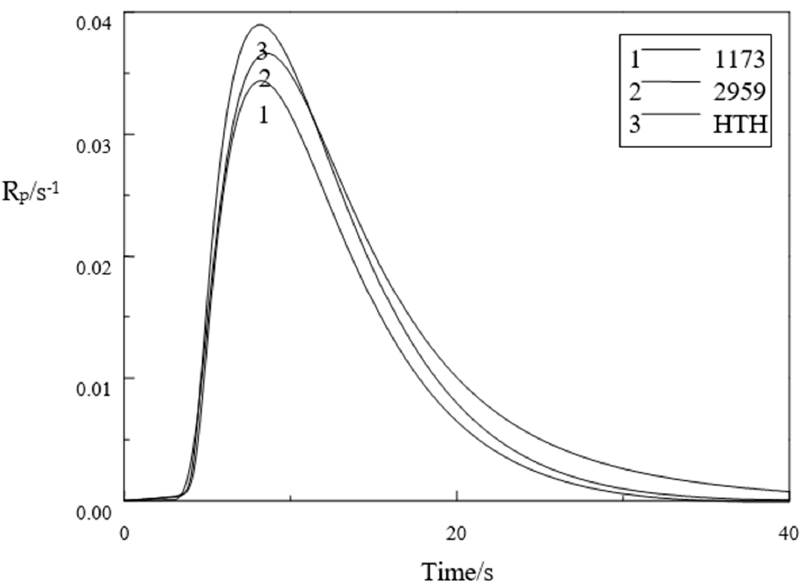
Figure 8. Curves of 1173, 2959, and HTH-initiated polymerization reaction rate of TMPTA.